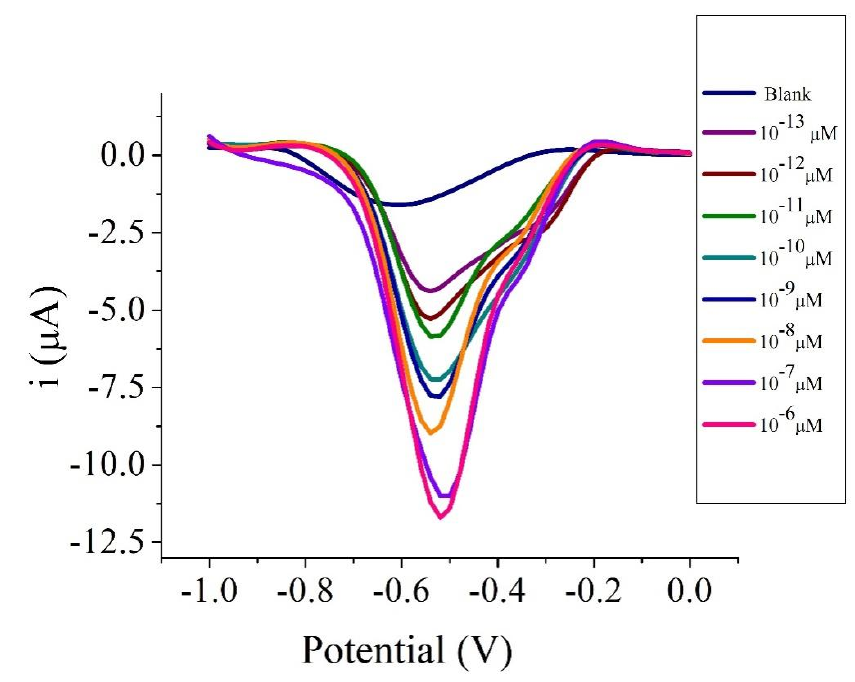
Figure 9. DPV of electrochemical DNA biosensor toward Arowana DNA target concentrations of 1 × 10 − 13 to 1 × 10 − 6 μ M. The biosensors were scanned in 10 mM PBS at pH 7 and 0.1 M KCl using a scan rate of 0.1 Vs − 1.